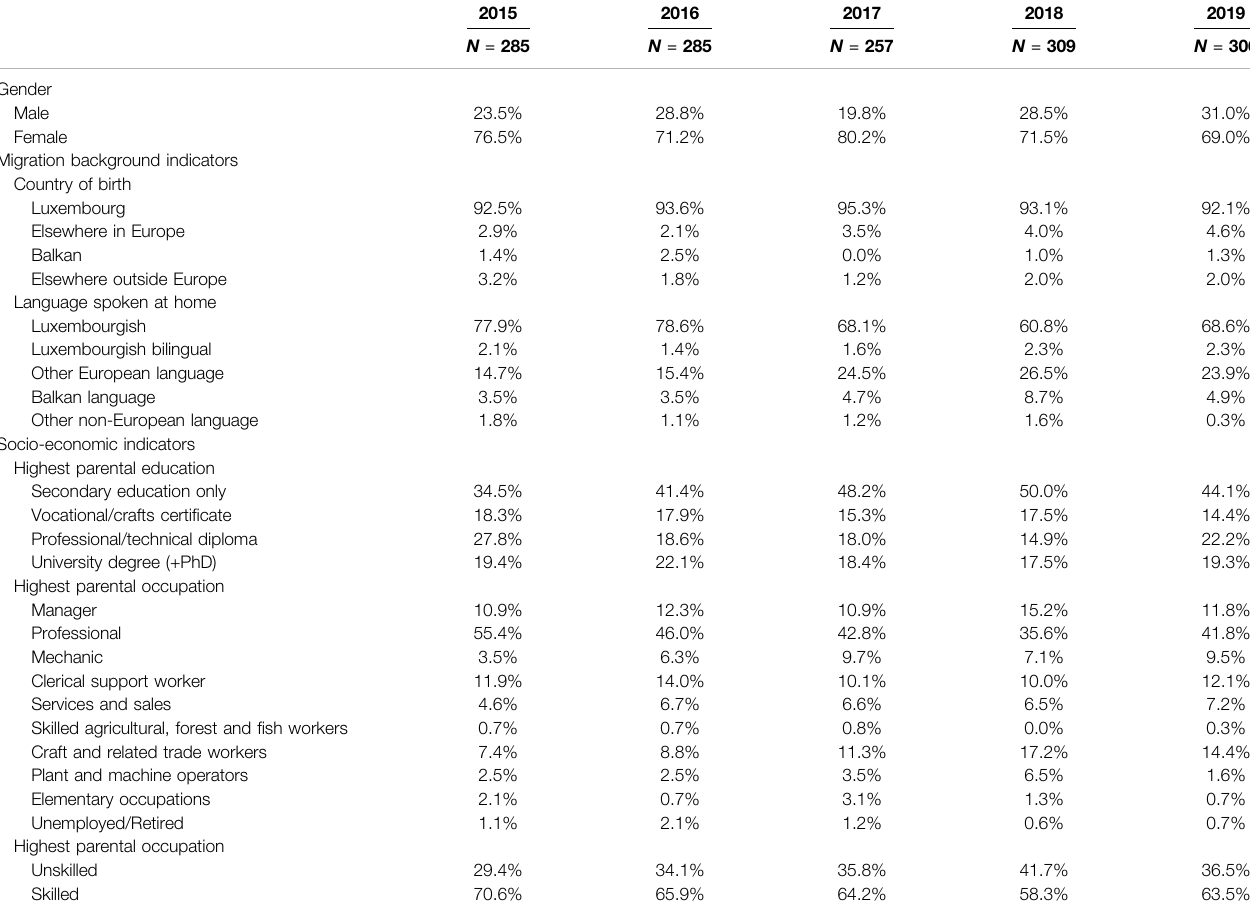
TABLE 1 | Demographic characteristics of candidates registering for the entree exam per year (2015 – 2019) a